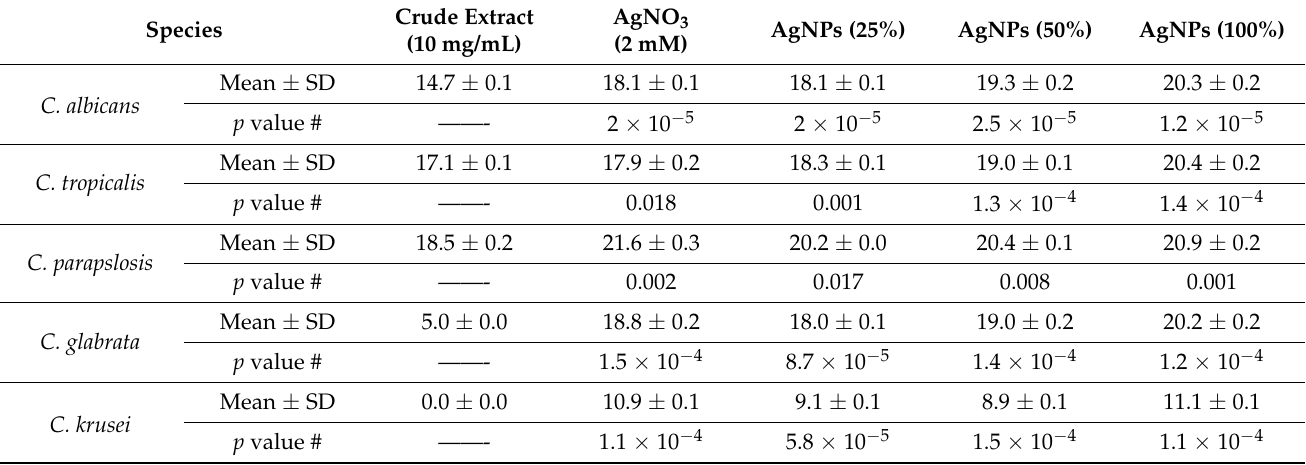
Table 3. Zone of inhibition for Candida spp. treated with AgNPs of the Palm leaves ethanolic extract.